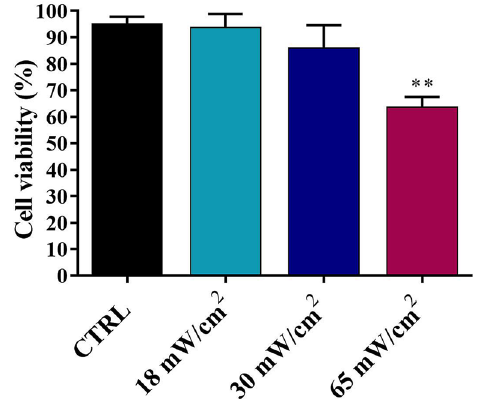
Figure 4. Cell proliferation analysis by MTT test on HaCaT cells exposed to 1 MHz US with I spta 18, 30 and 65 mW/cm 2 for 1 h. The reported values and error bars represent the average and the standard deviation evaluated on each sample analysed. Asterisks indicate significant difference from the control sample (**p < 0.01). The graph is representative of at least three independent experiments.